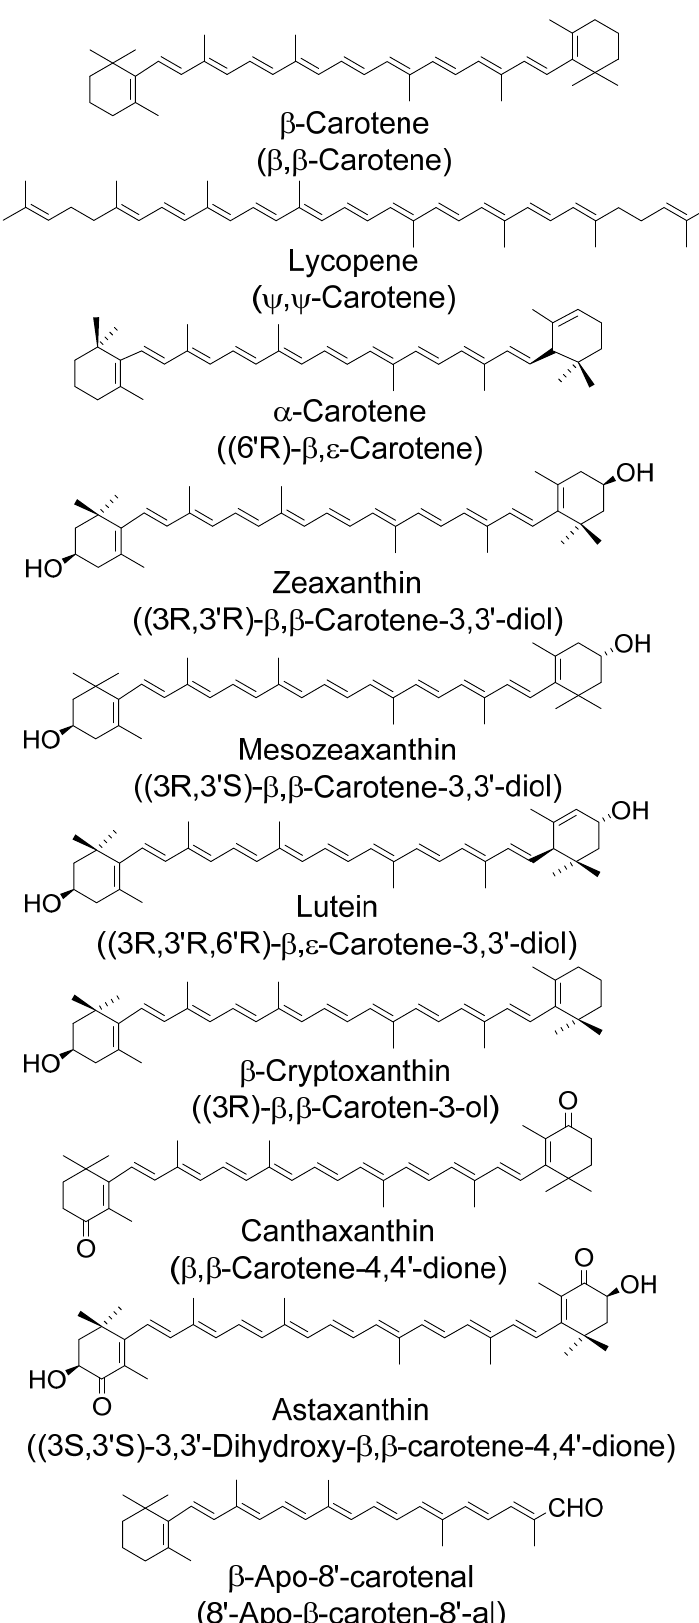
Figure 3. Structures of all-trans carotenoids and analogues.